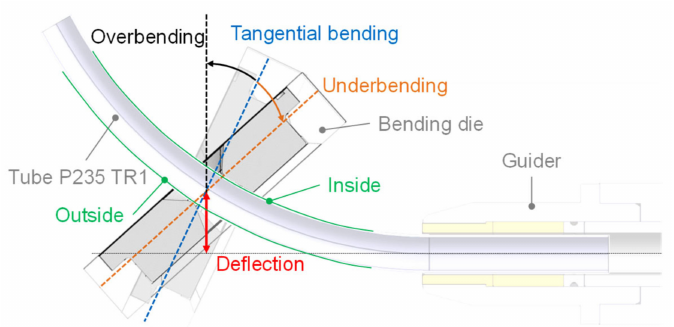
Figure 1. Schematic depiction of non-tangential bending (over- and underbending) for freeform bending with movable die. Adapted from Ref.